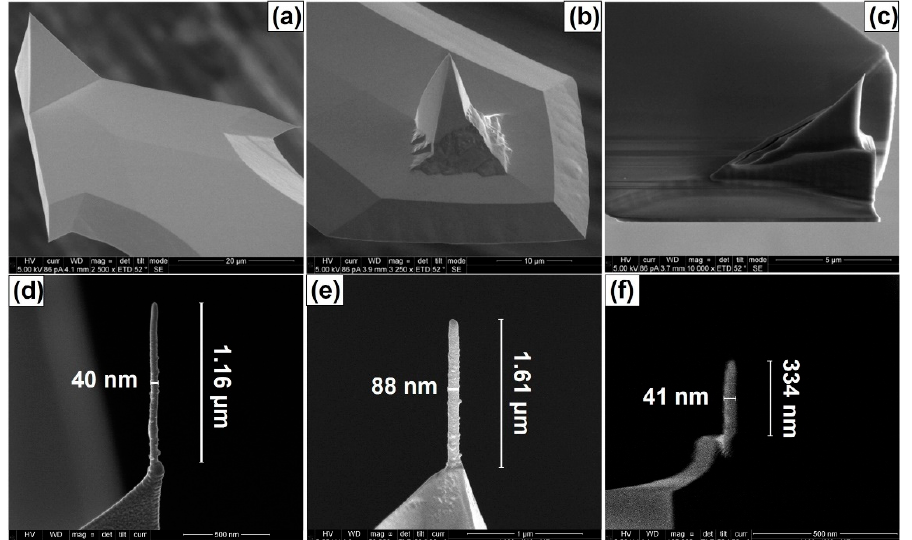
Figure 1. SEM images of ( a ) Nanoworld Arrow TM EFM , ( b ) Budget Sensors ® and ( c ) Olympus BioLever mini AFM probes, with their corresponding ( d , f ) Fe and ( e ) Co nanowires. ( a – c,f ) adapted from [61] and ( d , e ) reproduced from [41] with permission from the Royal Society of Chemistry.